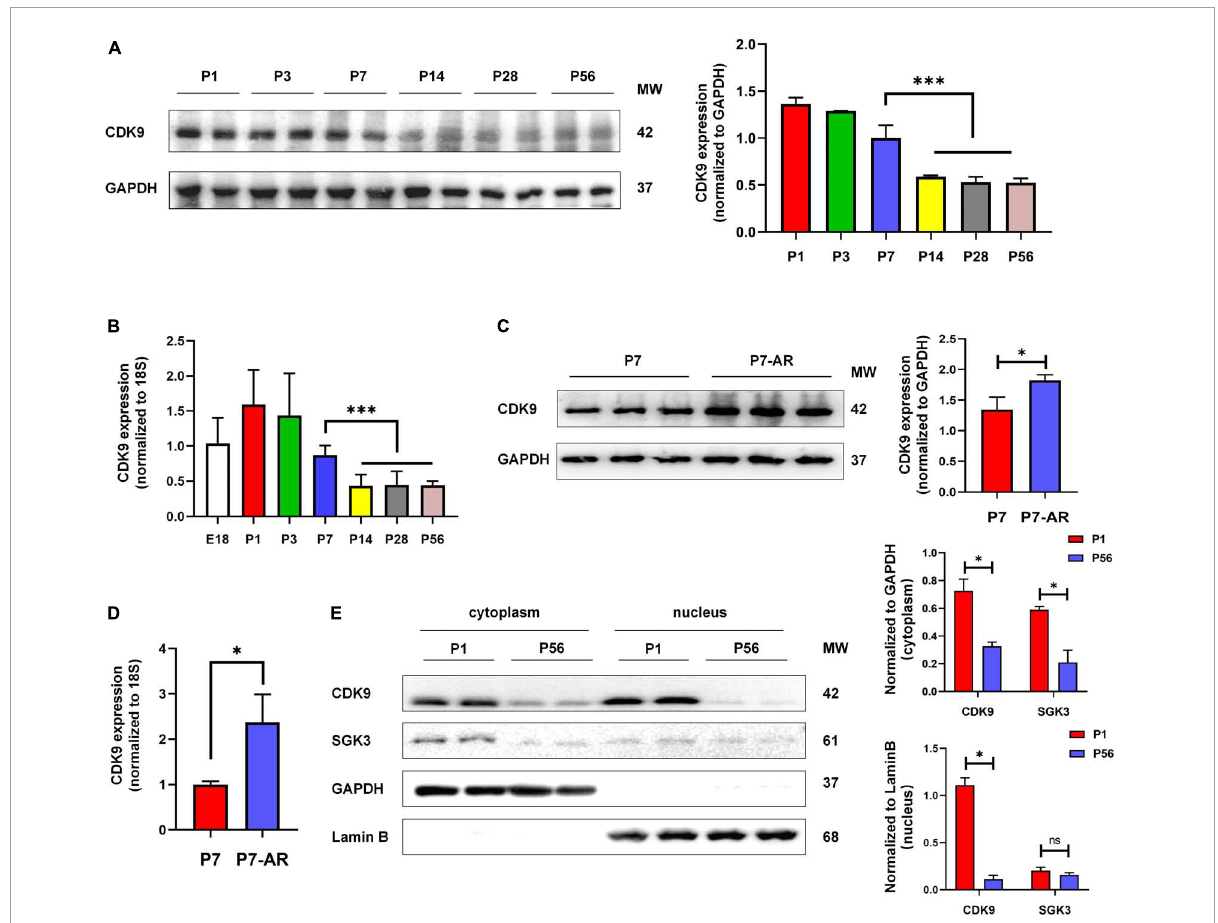
FIGURE2 Expression pattern and subcellular localization of CDK9. (A) CDK9 proteins of ventricular myocardium detected by western blot in P1–P56 mice. (B) mRNA expression levels of CDK9 in embryo and P1–P56 mice. (C) CDK9 proteins of ventricular myocardium detected by western blot in P7 and P7-AR mice. (D) mRNA expression levels of CDK9 in P7 and P7-AR mice. (E) SGK3 and CDK9 proteins of ventricular myocardium in P1 and P56 mice submitted to nucleocytoplasmic fractionation. MW indicates molecular weight, AR indicates apical resection; statistical significance was calculated with the unpaired Student t -test; data are presented as mean ± SEM, ∗ P ≤ 0.05, ∗∗∗ P ≤ 0.001; each dot indicates a biological